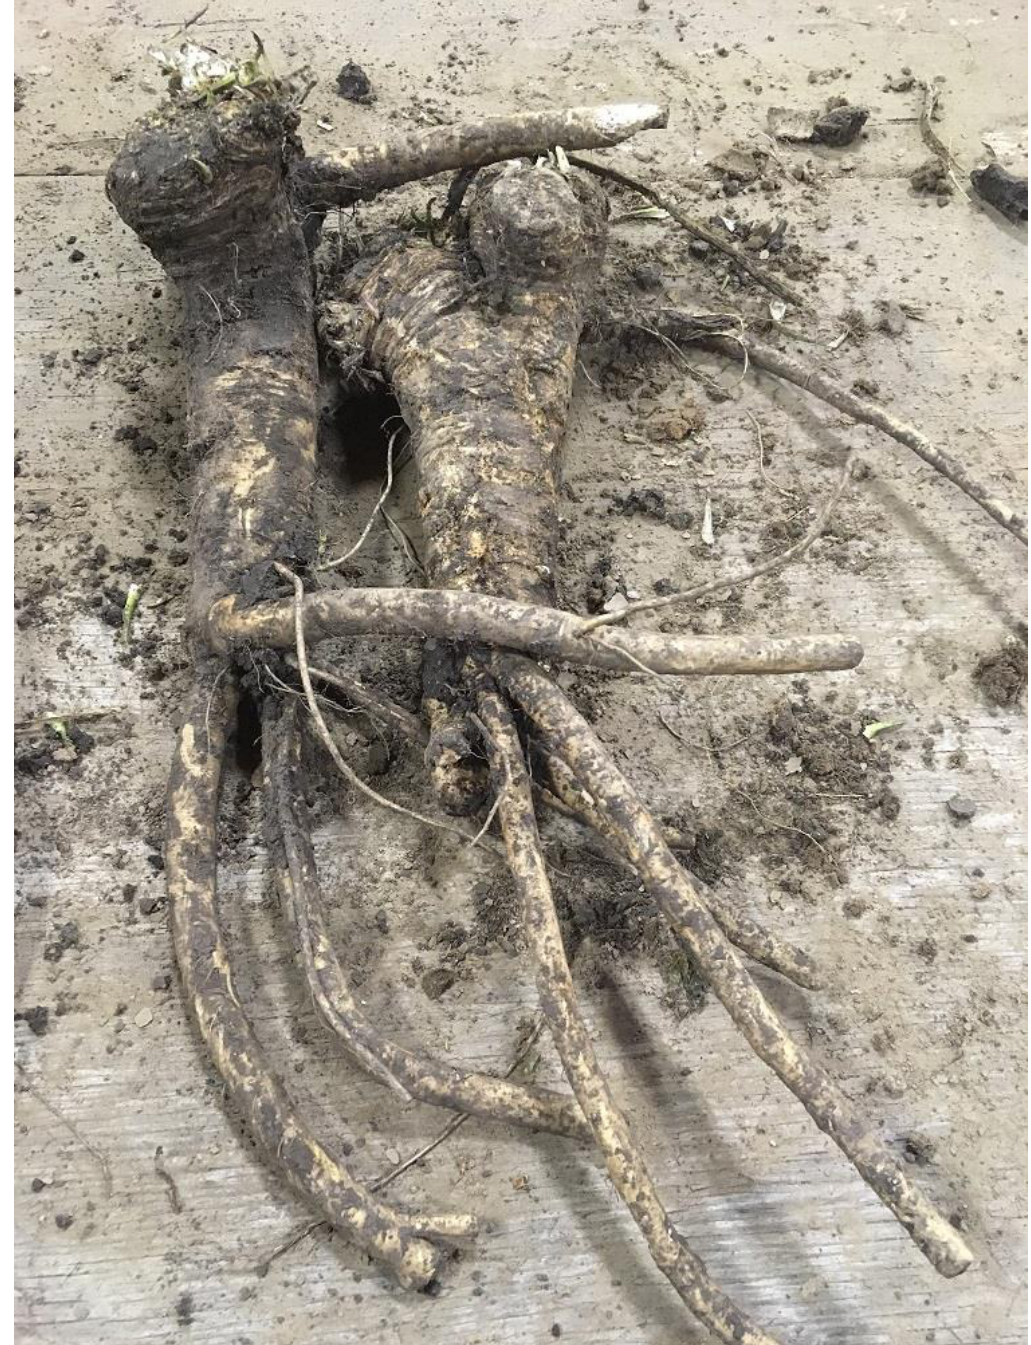
Figure 3. Horseradish cultivar 906, released in 2012 from the Illinois, USA breeding program. This cultivar resulted from a proven cross of 1573 (high primary root biomass, but highly susceptibility to internal root discoloration) × 315 (high primary root biomass and high tolerance to internal root discoloration) (photo by Dr. Alan Walters).